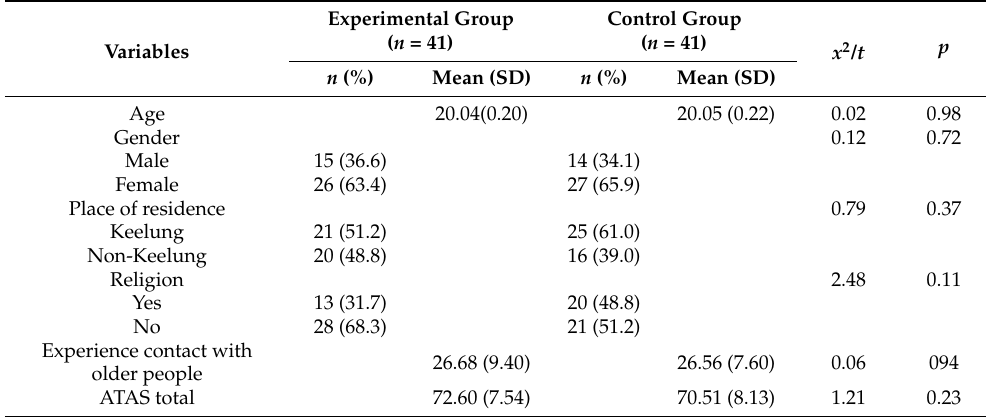
Table 2. Personal characteristics and baseline data of nursing students by group ( n =